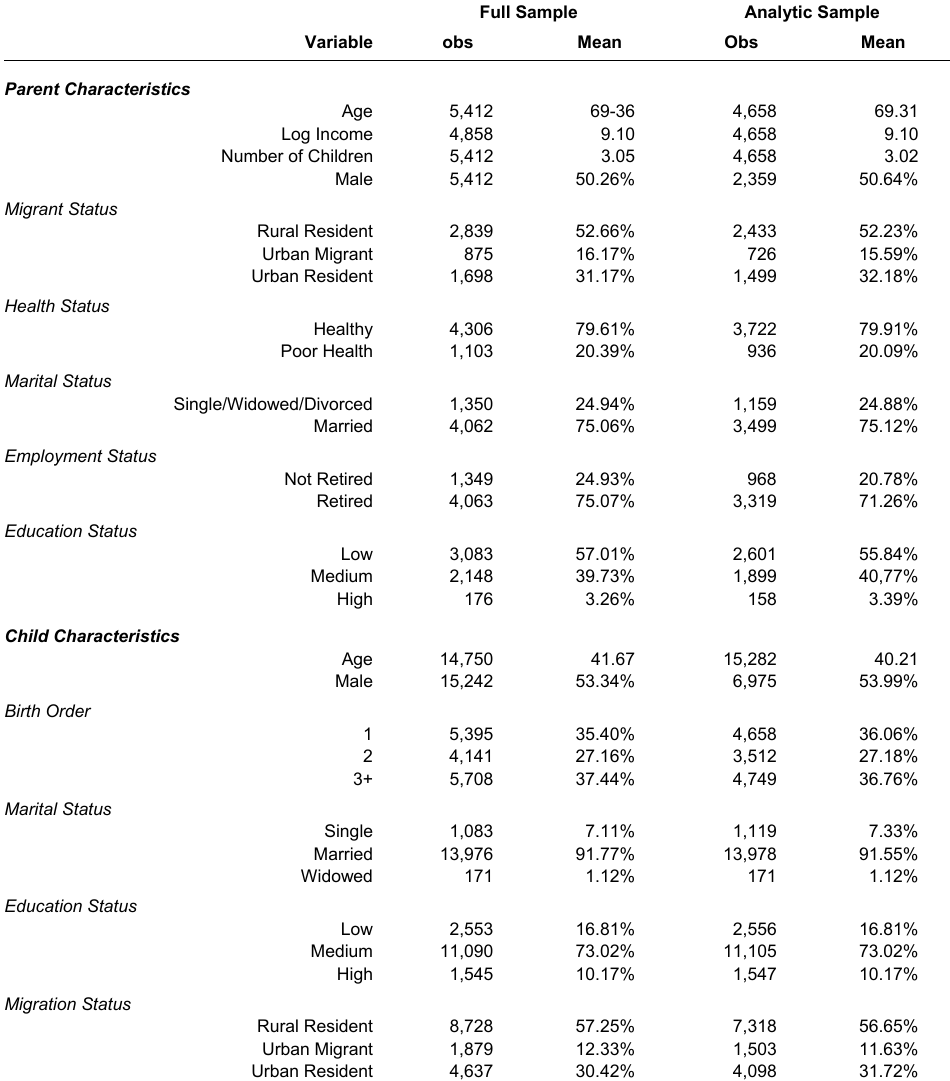
Parent and Child Characteristics Full Sample Analytic Sample Variable obs Mean Obs